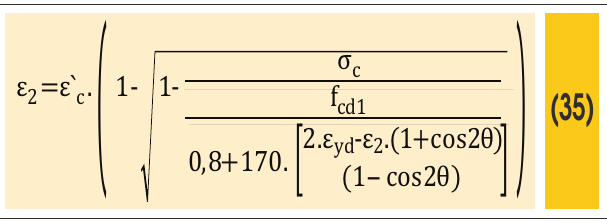
Figure 4 – Compressive strength of concrete as a function of θ to case